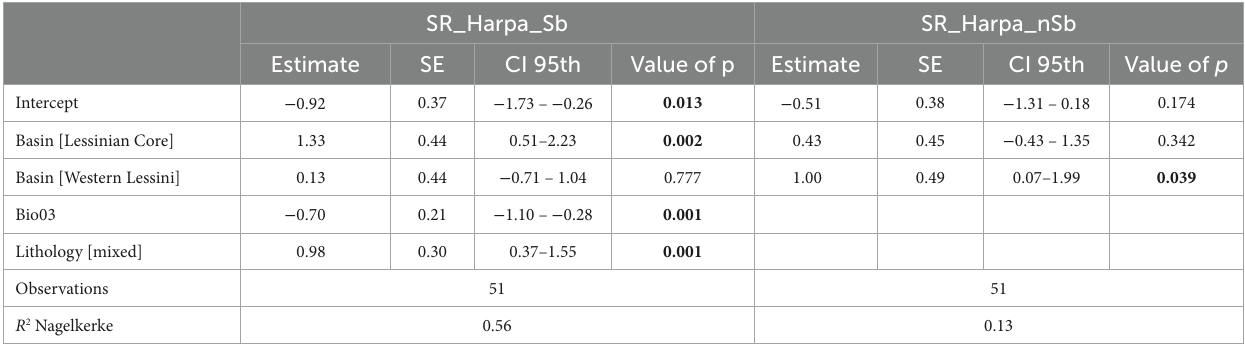
TABLE 5 Results from the refined Generalized Linear Model (GLM) relating species richness of stygobitic Harpacticoida (SR_Harpa_Sb) to drainage basin, isothermality (Bio03) and lithology, and from the refined GLM relating species richness of non-stygobitic Harpacticoida (SR_Harpa_nSb) to basin only.